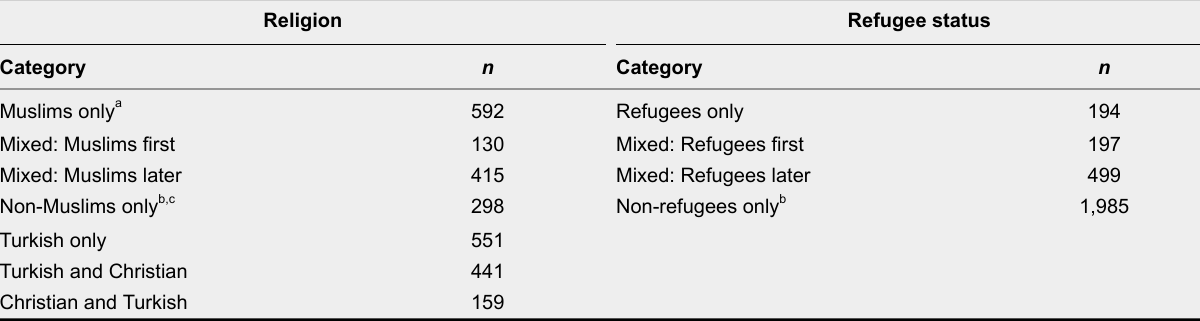
Categories for and Distribution of Salient